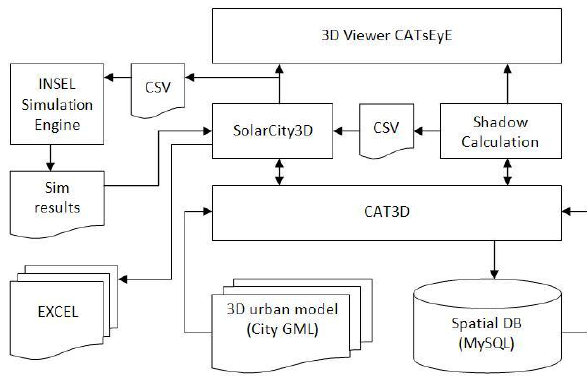
Figure 4. System Architecture (Alam et al, 2011)